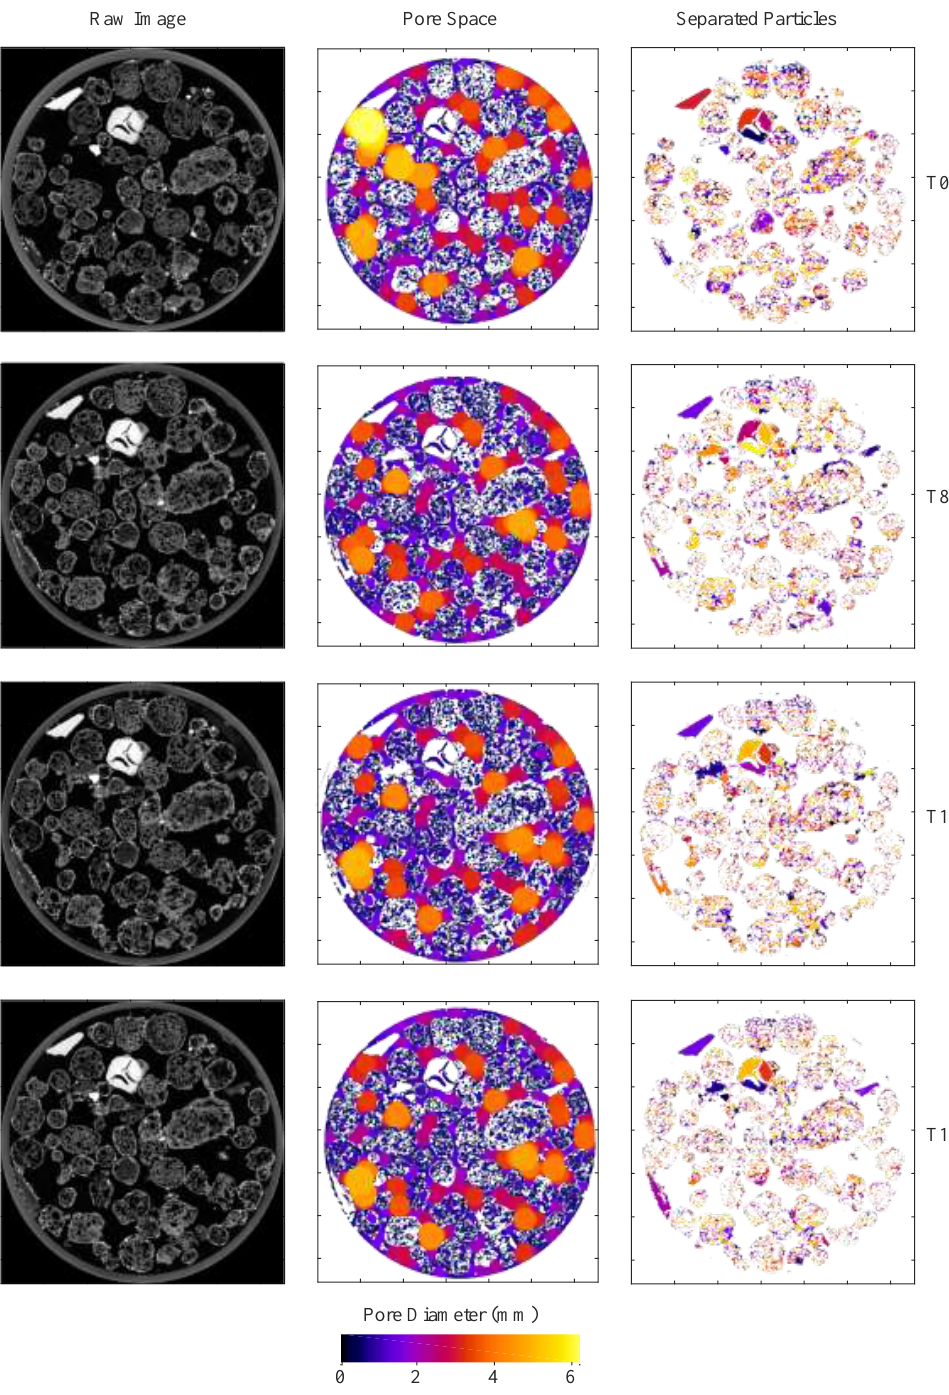
Figure 7. Example slices of unprocessed and processed XMT images for LECA-Sedum substrate microcosms. All images are 52.4 mm across.